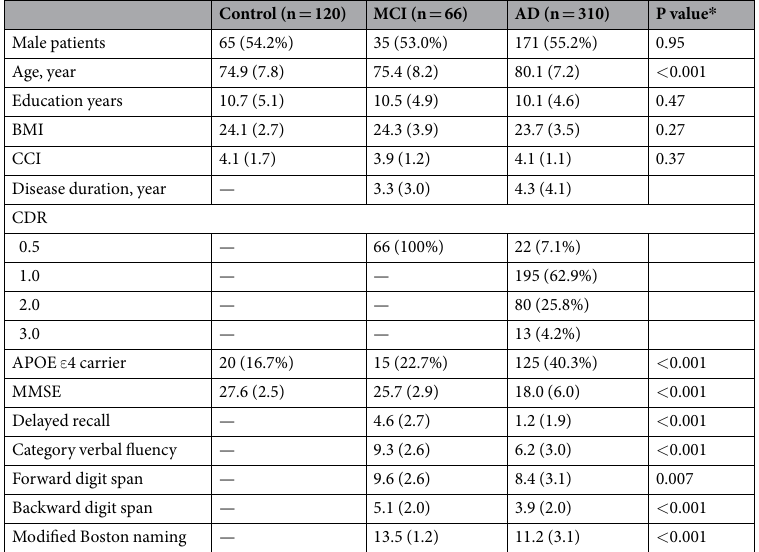
Table 1. Demographic and neuropsychiatric data of the study subjects. The values indicate means with standard deviations unless otherwise indicated. Post hoc Tukey test: Age: AD vs. control, p < 0.001; AD vs. MCI, p < 0.001; MMSE: AD vs. control, p < 0.001; AD vs. MCI, p < 0.001; MCI vs. control, p = 0.04. MCI, mild cognitive impairment; AD, Alzheimer’s disease; BMI, body mass index; CCI, Charlson comorbidity index; CDR, Clinical Dementia Rating; APOE, apolipoprotein E; MMSE, Mini-Mental Status Examination. *